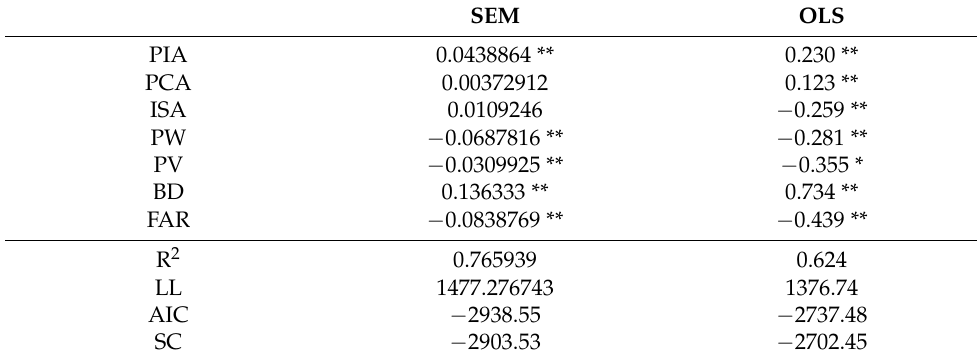
Table 5. Comparison of OLS and